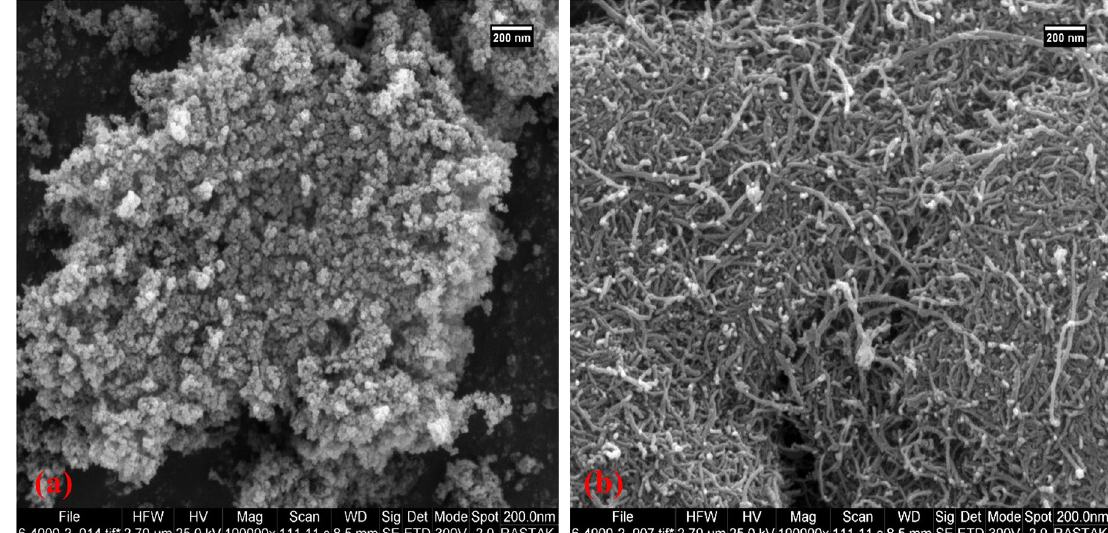
Figure 3. SEM images of ( a ) TiO 2 , ( b ) MWCNTs.